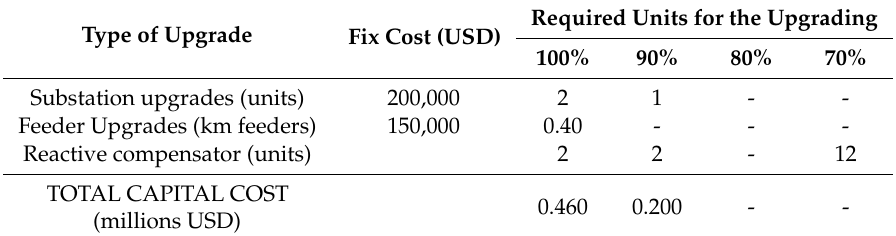
Table 12. Fixed cost of the planning solutions for each scenario proposed.